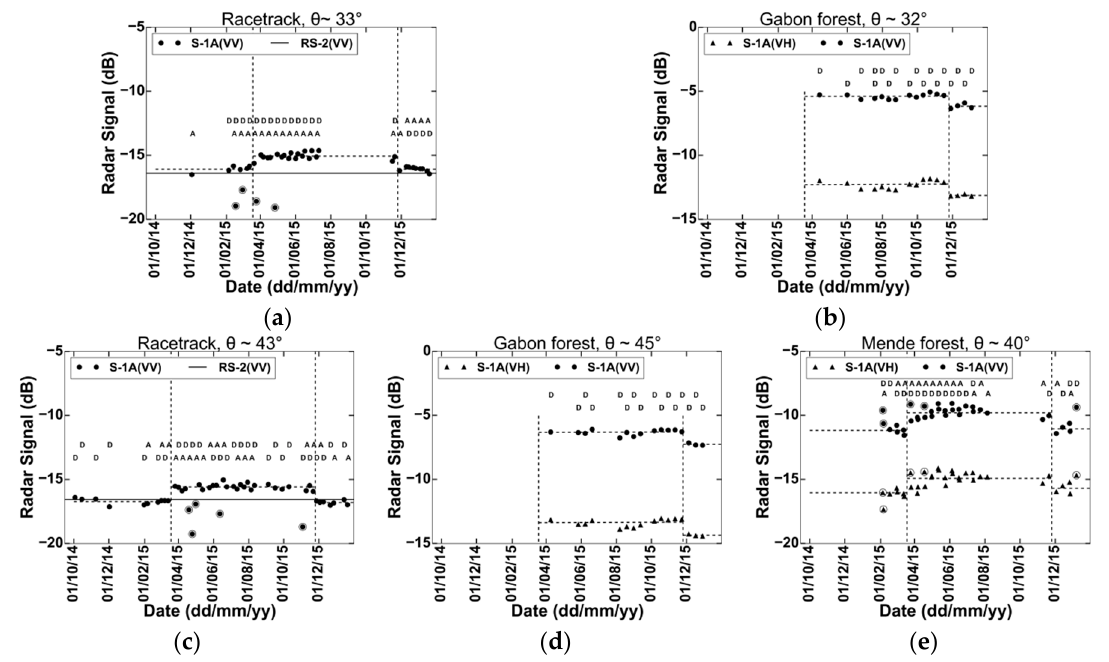
Figure 2. Temporal variations of S-1A σ ° in both VH and VV polarizations at medium ( a , b ) and high ( c – e ) incidence angles. Dashed vertical lines to the left and right refer to trends for 19 March 2015 and 25 November 2015, respectively. Continuous horizontal black lines in ( a ) and ( c ) denote RS-2 σ ° for VV polarization. A: Ascending mode; D: Descending mode. Circles denote the S-1A σ ° affected by rainfall.